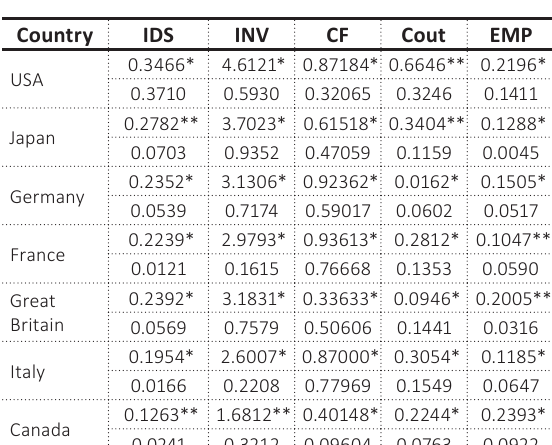
Table 3. Multiple regressions for accounting